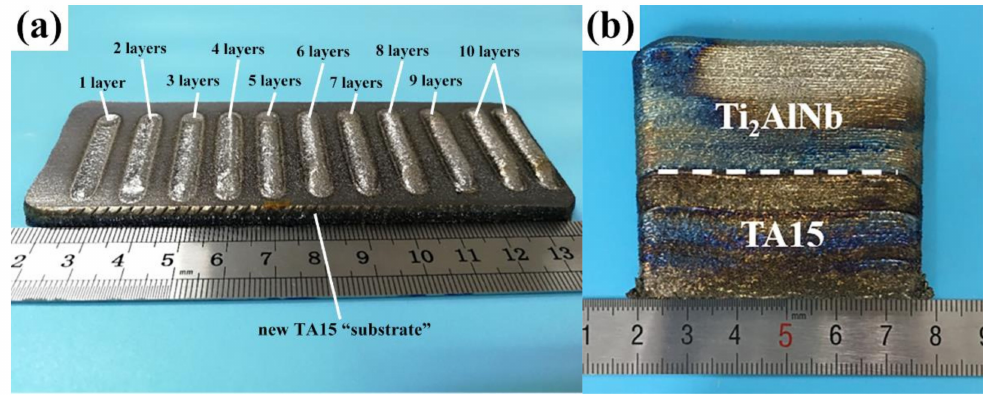
Figure 2. Samples fabricated by laser solid forming (LSF): ( a ) multiple-layer samples fabricated in Experiment 1 (E1); ( b ) dual-alloy sample fabricated in Experiment 2